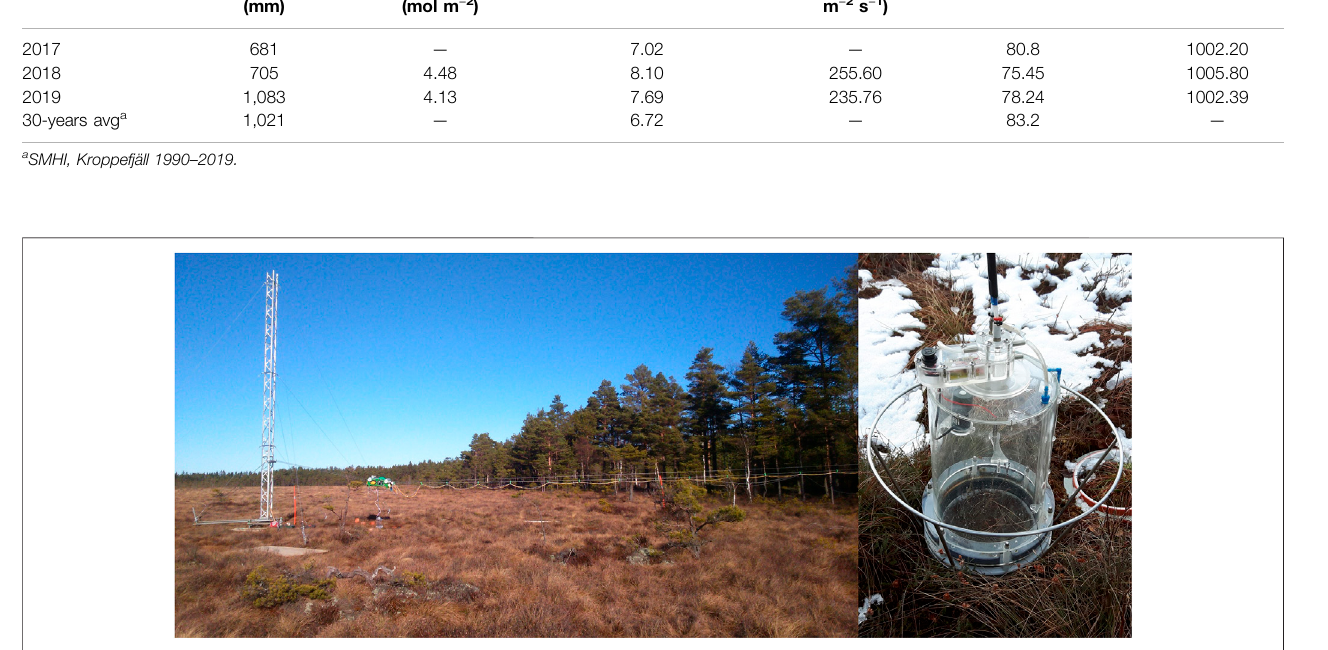
Frontiers in Earth Science |